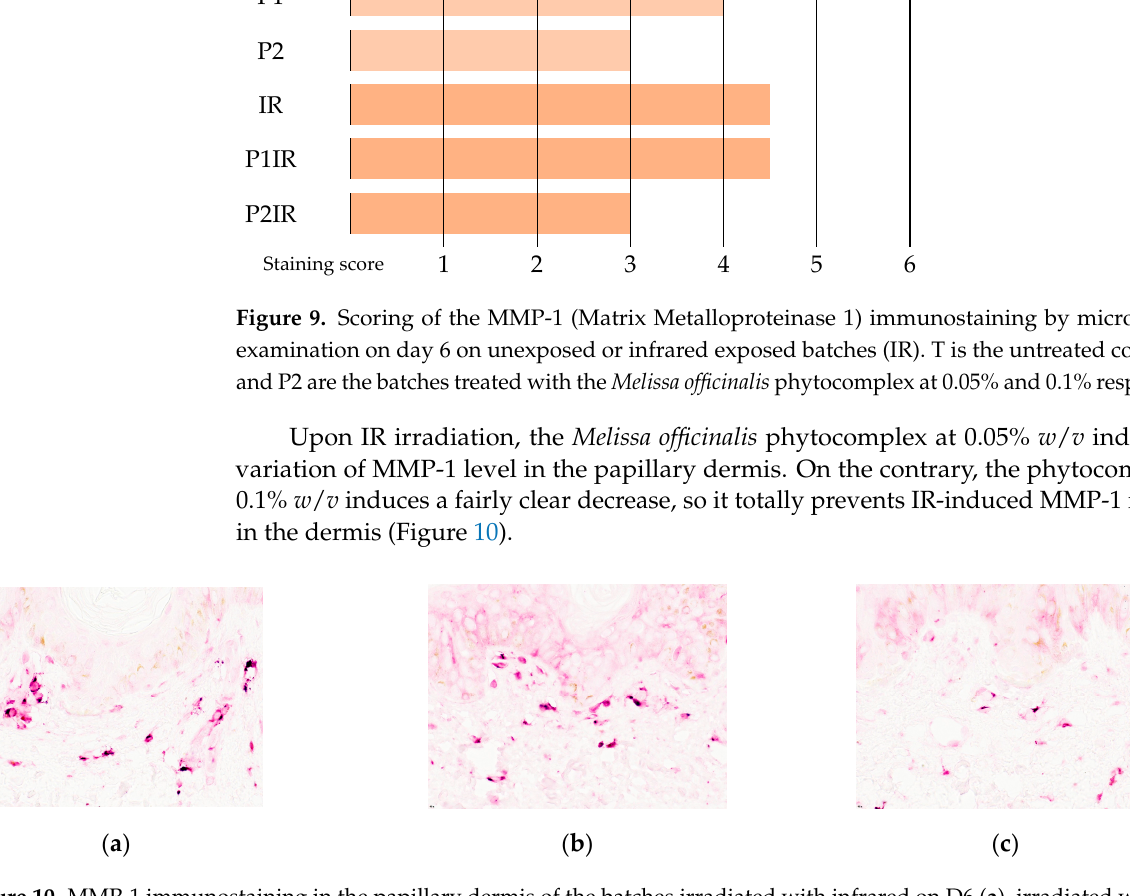
Figure 8. Elastin immunostaining in the papillary dermis of the batches irradiated with infrared on D6 ( a ), irradiated with infrared and pre-treated with the Melissa officinalis phytocomplex at 0.05% ( b ) or 0.1% w/v ( c ), on D6.